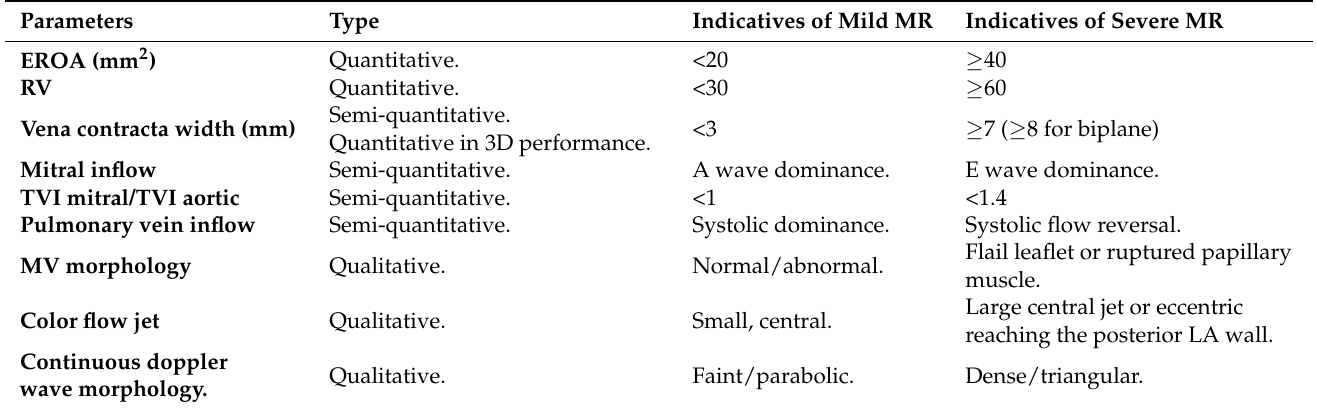
Table 2. Integration of different severity assessment indexes. EROA (regurgitant orifice area),